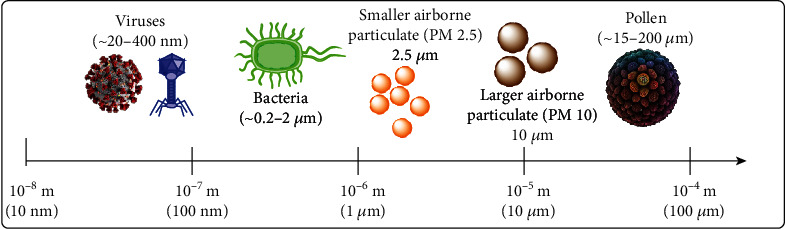
Relative size chart of common airborne contaminants and pathogens.